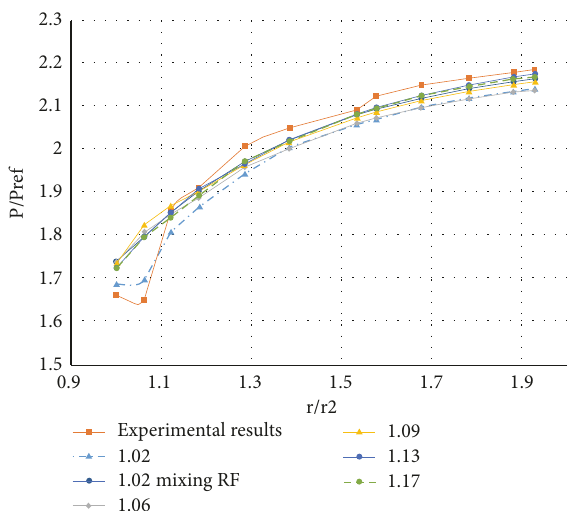
Figure 12: Domain interface position pressure distribution at a spanwise distance of 0.9, 461 Hz, and 1.8 kg/s mass flow